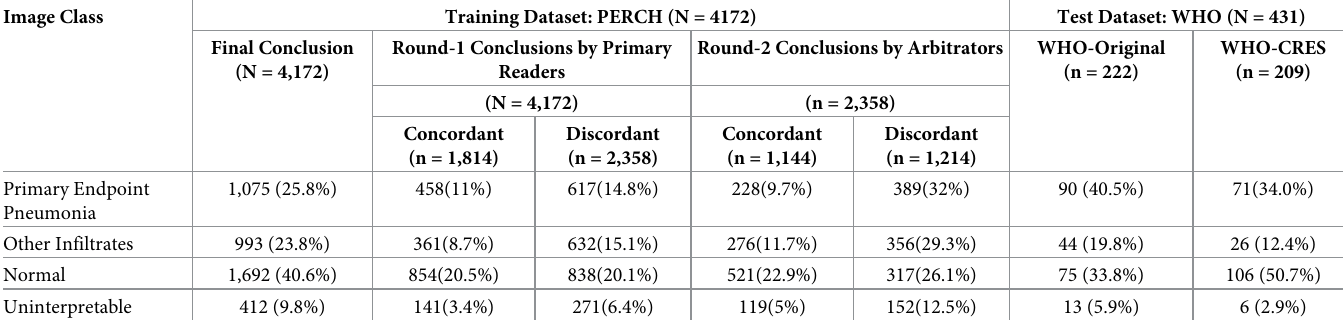
Table 1. Conclusions of CXR-reading by radiologists and pediatricians in training (PERCH) and testing (WHO) datasets. Image